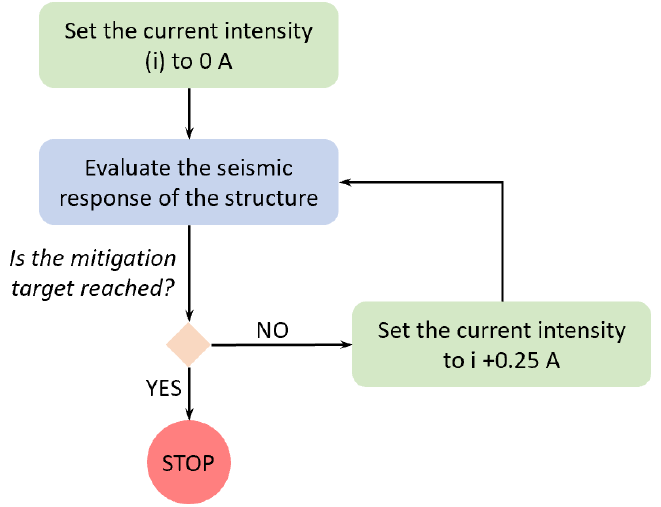
Figure 24. Calculation loop for the individuation of the activation current compliant with the vibration-mitigation target (defined in Section 3).